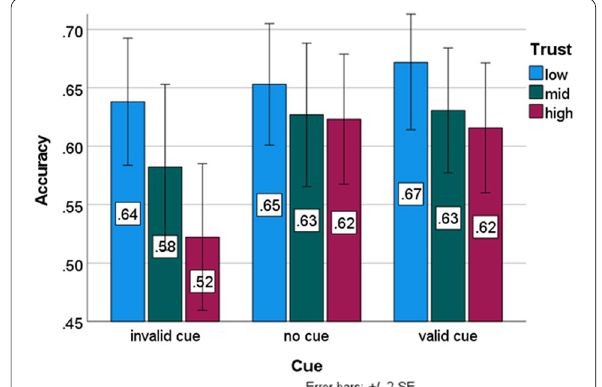
Fig. 7 Average accuracy per level of trust (low, mid, high) and per cueing condition (invalid, no cue, valid). Presentation time is until response. Both a low trust in the authenticity (i.e. a high expectancy on the number of counterfeits) and valid cueing led to better performance. Error bars depict 95% confidence